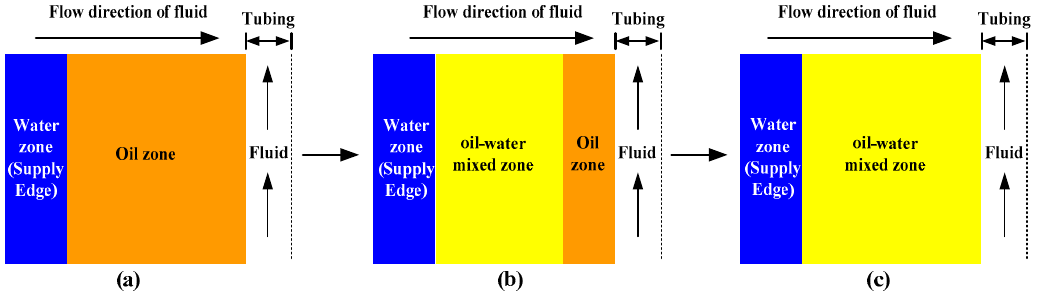
Figure 1. Schematic illustration of the water displacing oil process for 1-D plane-radial flow: ( a ) the initial state ( t = 0); ( b ) before the water breakthrough time for tubing ( t < t w ); (c) after the water breakthrough time for tubing ( t ≥ t w ).